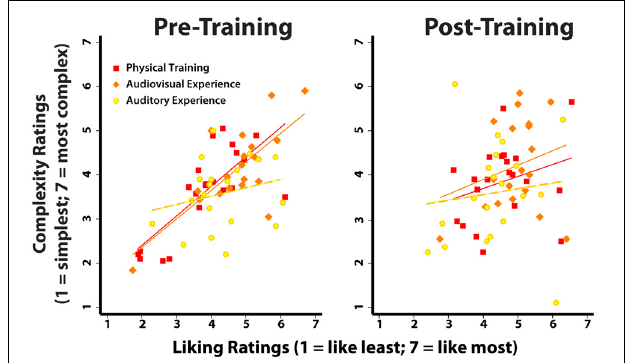
and after training. The left plot illustrates the positive correlation between liking and complexity before participants had any kind of experience with the dance stimuli [similar to the situation in Cross et al. (2011)]. The lines represent the regression lines of the correlation for each group, pre- and post-training (see the Results section for r- and p- values). The right plot illustrates that the positive correlation evident for the Physical Training and the Audiovisual Experience groups disappears after several days of training, such that those movements that are viewed as most complex are no longer associated with consistently high liking